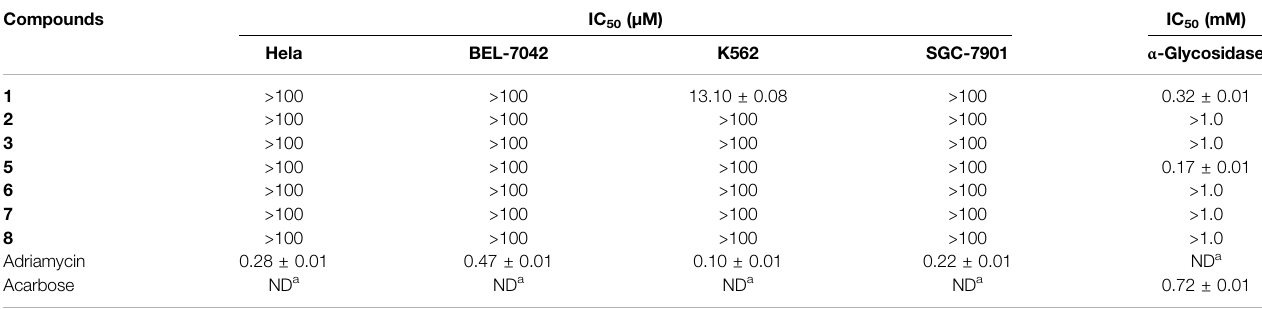
TABLE 3 | IC 50 values of cytotoxicity and α -glycosidase inhibitory activity of compounds 1 – 3 and 5 – 8 . Compounds IC 50 ( μ